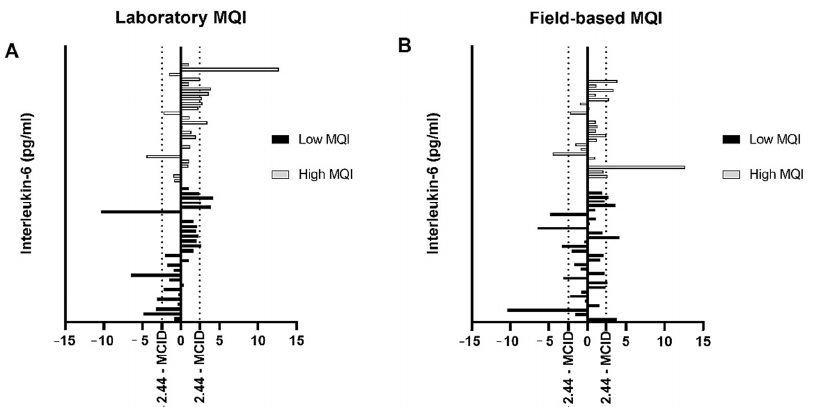
Figure 4. Responsiveness for the interleukin 6 (IL ‐ 6) levels based on minimal clinical important dif ‐ ference (MCID). ( A ) Laboratory IL ‐ 6 levels; ( B ) field ‐ based IL ‐ 6 levels.